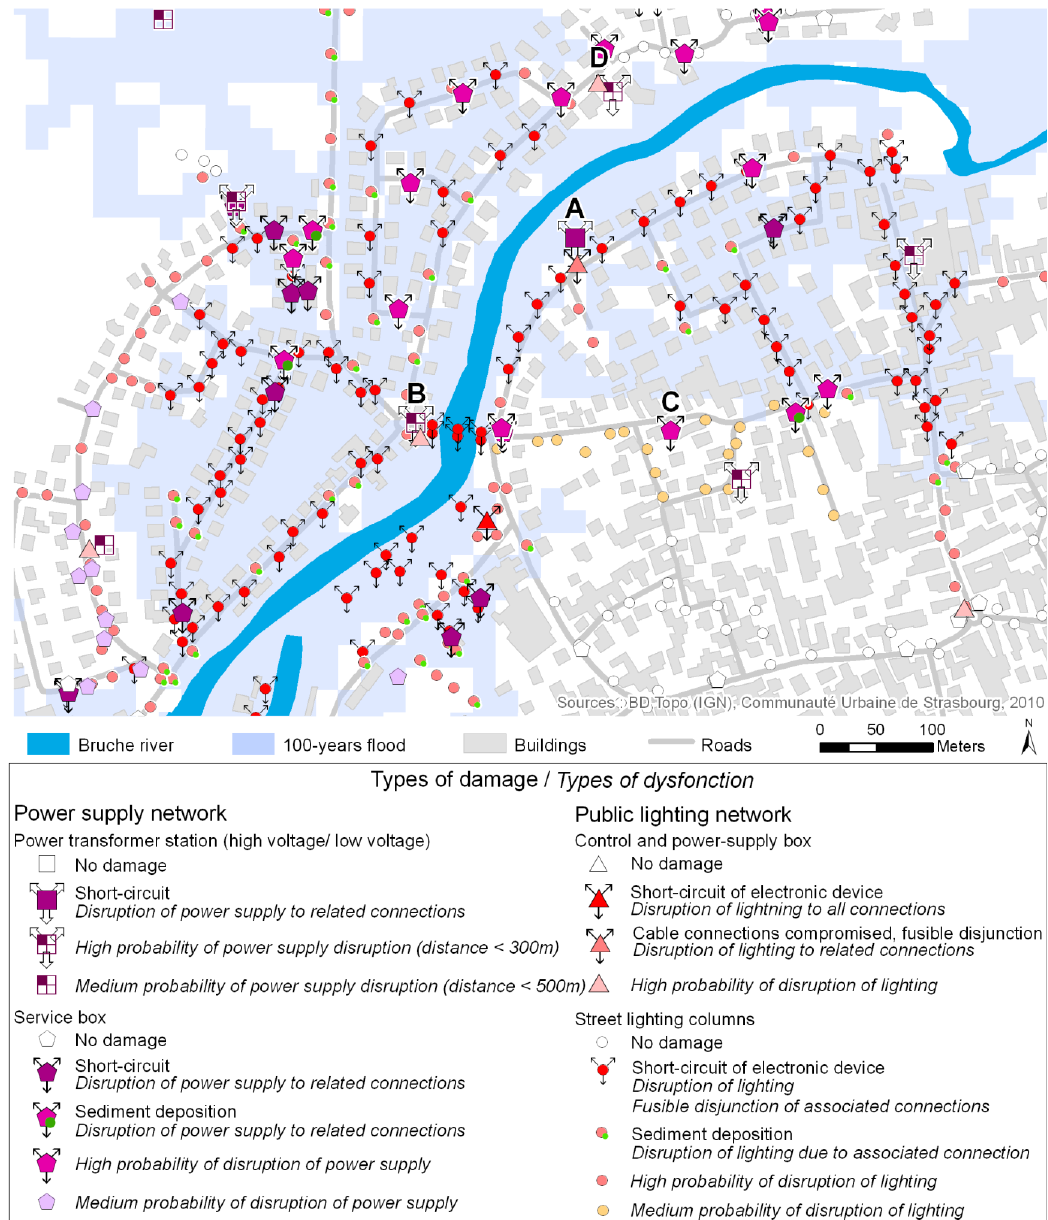
Figure 5. Map of damage-dysfunctions caused by a flood with a 100-year return-period for the 2 components of public lighting and power supply networks. 3